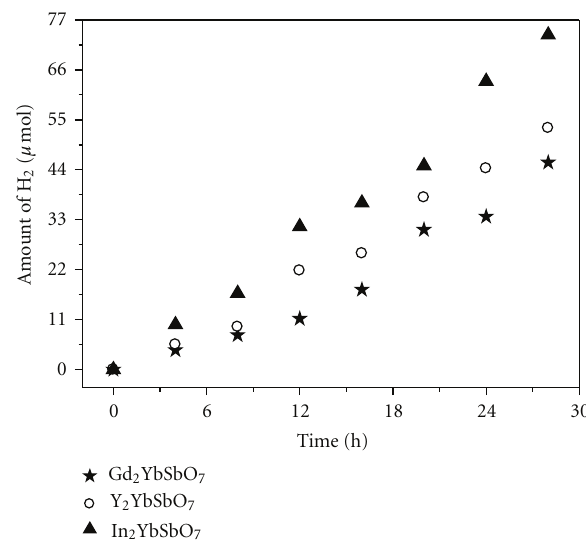
Figure 3: Photocatalytic H 2 evolution from aqueous methanol solution with Y 2 YbSbO 7 , In 2 YbSbO 7 , or Gd 2 YbSbO 7 as catalyst under visible light irradiation ( λ > 420nm, 0.5 g 0.1 wt% Pt-loaded powder sample, 50 mL methanol solution, 200 mL pure water). Light source: 300W Xe